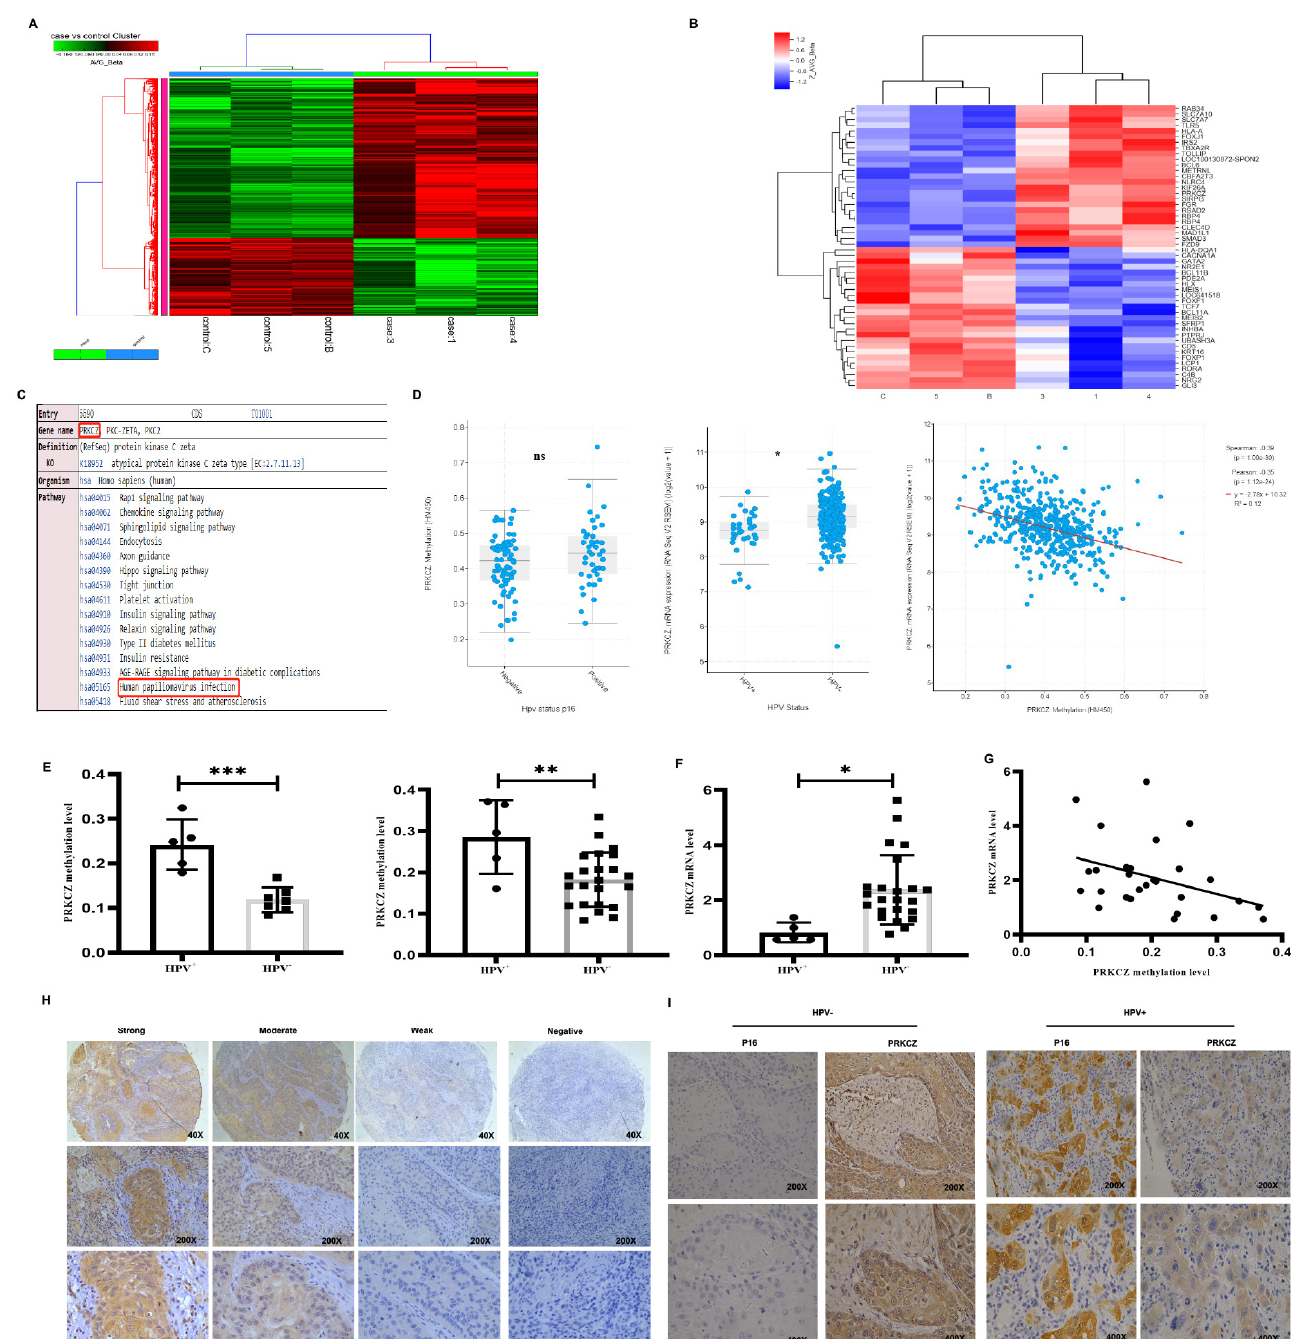
Figure 1. PRKCZ is hypermethylated in HPV+ HNSCC. ( A ) Cluster analysis heat map of different hypermethylated and hypomethylated genes in HPV+ HNSCC and HPV- HNSCC. ( B ) Cluster anal- ysis heat map of different Top 25 significantly hypermethylated and 25 obviously hypomethylated genes in HPV+ HNSCC, compared with HPV- HNSCC. ( C ) KEGG enrichment analysis of PRKCZ in Illumina methylation chip and its role in HPV infection. C, 5, and B represented HPV-negative HNSCC patients, while 1, 3, and 4 represented HPV-positive HNSCC patients. ( D ) PRKCZ methyla- tion degree and mRNA expression level in HPV+ and HPV- HNSCC in TCGA database. PRKCZ methylation degree is inversely associated with mRNA expression level (r = − 0.34). ( E ) PRKCZ was hypermethylated in HPV+ HNSCC paraffin-embedded tissues and fresh tissues, compared with HPV- samples. The left represented paraffin-embedded tissues, and the right represented